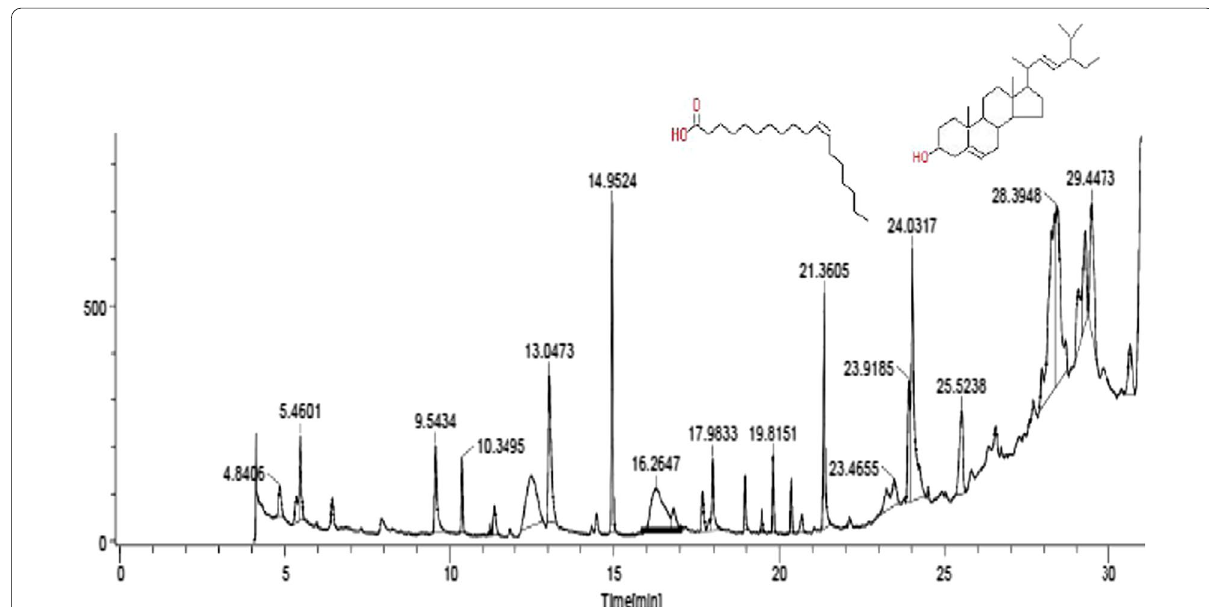
Fig. 2 GC–MS chromatogram of root methanolic extracts of Solanum khasianum . Stigmasterol (23.18%) with anti-inflammatory, antioxidant, antimicrobial and sedative properties. cis -Vaccenic acid (9.07%), potent anti-cancerogenic